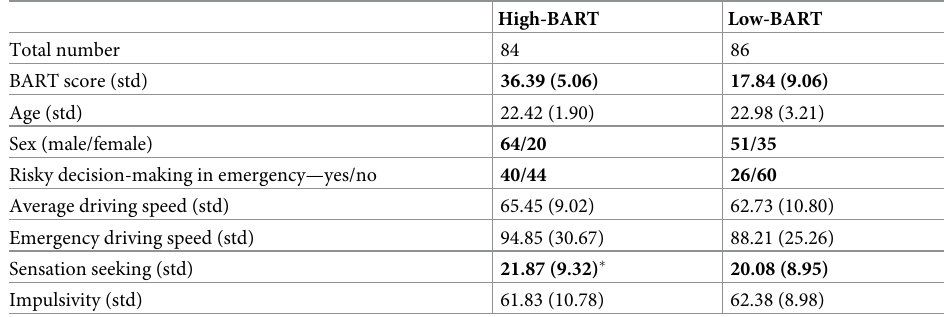
Table 4. Descriptive statistics for the high- and low-BART groups.